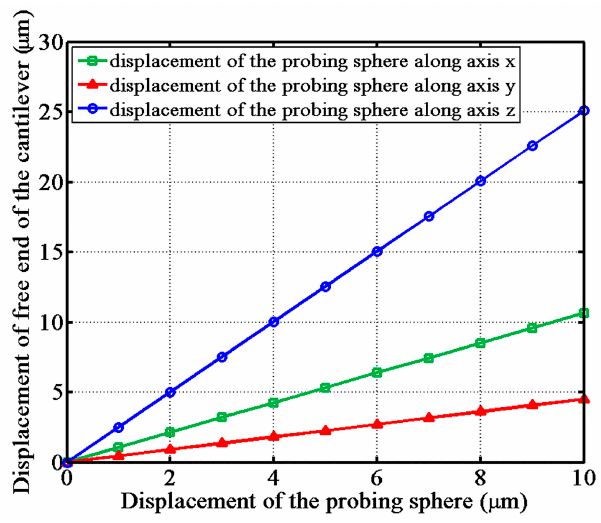
Figure 4. The displacement relationship of the probing sphere and the free end of the fiber cantilever obtained by finite element analysis.